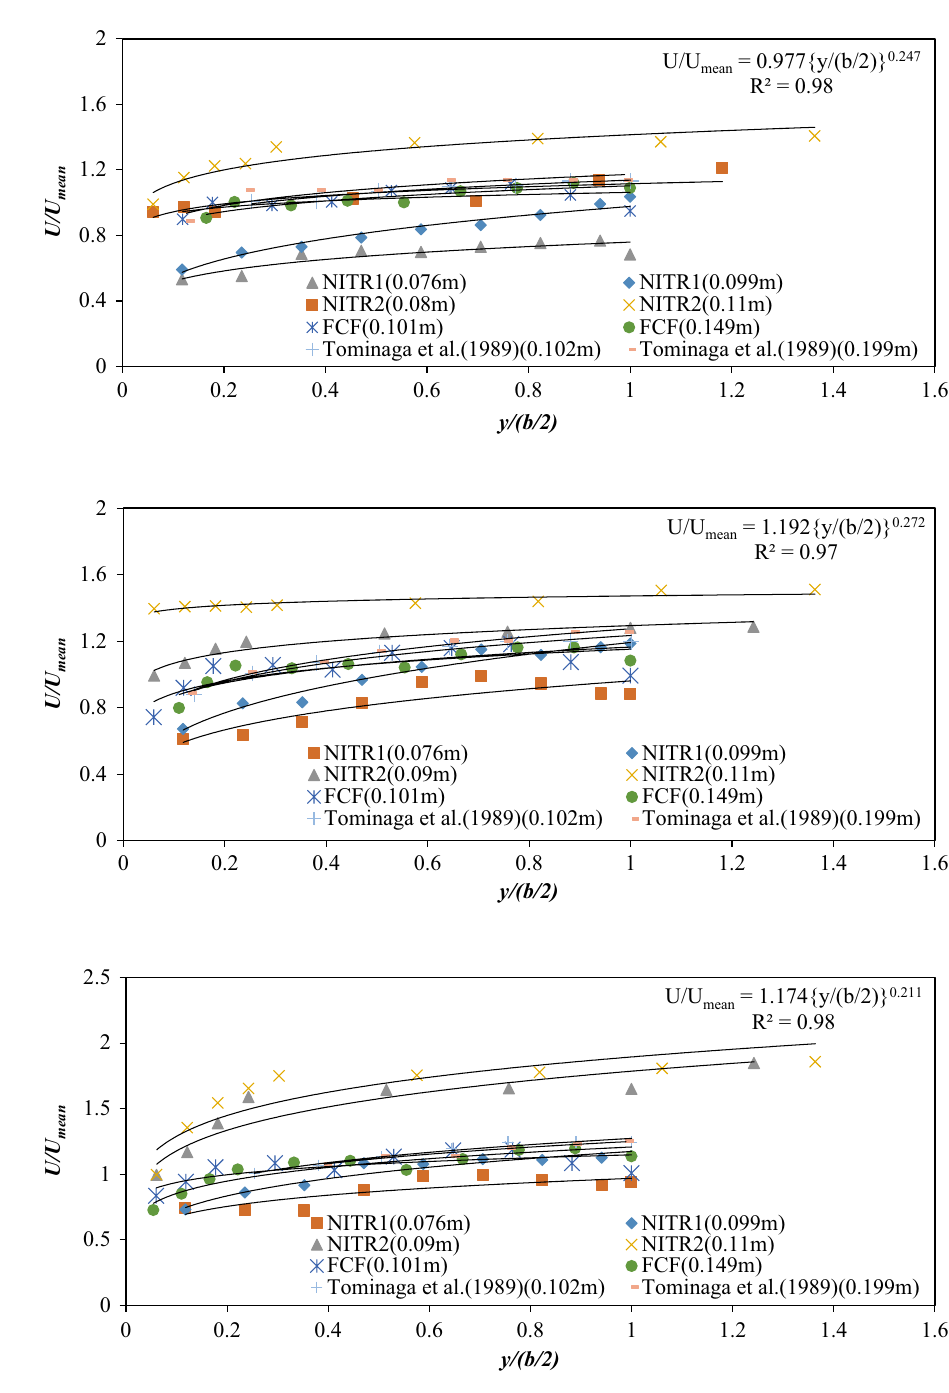
U/U = 1.174{y/(b/2)} 0.211 mean R² =